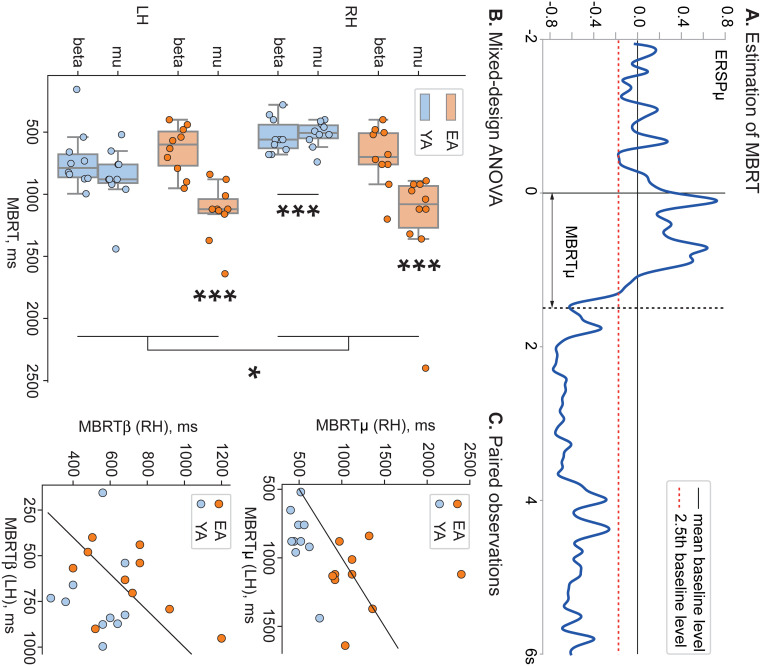
Motor brain response time.A An exemplary illustration of the MBRTμ estimation. The blue curve shows single-subject ERSPμ at the C4 sensor averaged over 15 LH epochs. Black solid and red dashed horizontal lines indicate mean and 2.5th percentile level of the baseline ERSPμ, respectively. Black solid and black dashed vertical lines show the beginning of the audio command and estimated motor brain response, respectively. B Distribution of MBRTμ,β across subjects in each (group,condition)-set. Here, ‘*’ indicates p < 0.05 and ‘***’ indicates p < 0.001. C Scatterplots of paired observations: (top) MBRTμ(RH) versus MBRTμ(LH) and (bottom) MBRTβ(RH) versus MBRTβ(LH) for each subject. Here, the diagonal line is MBRTμ,β(RH) = MBRTμ,β(LH).